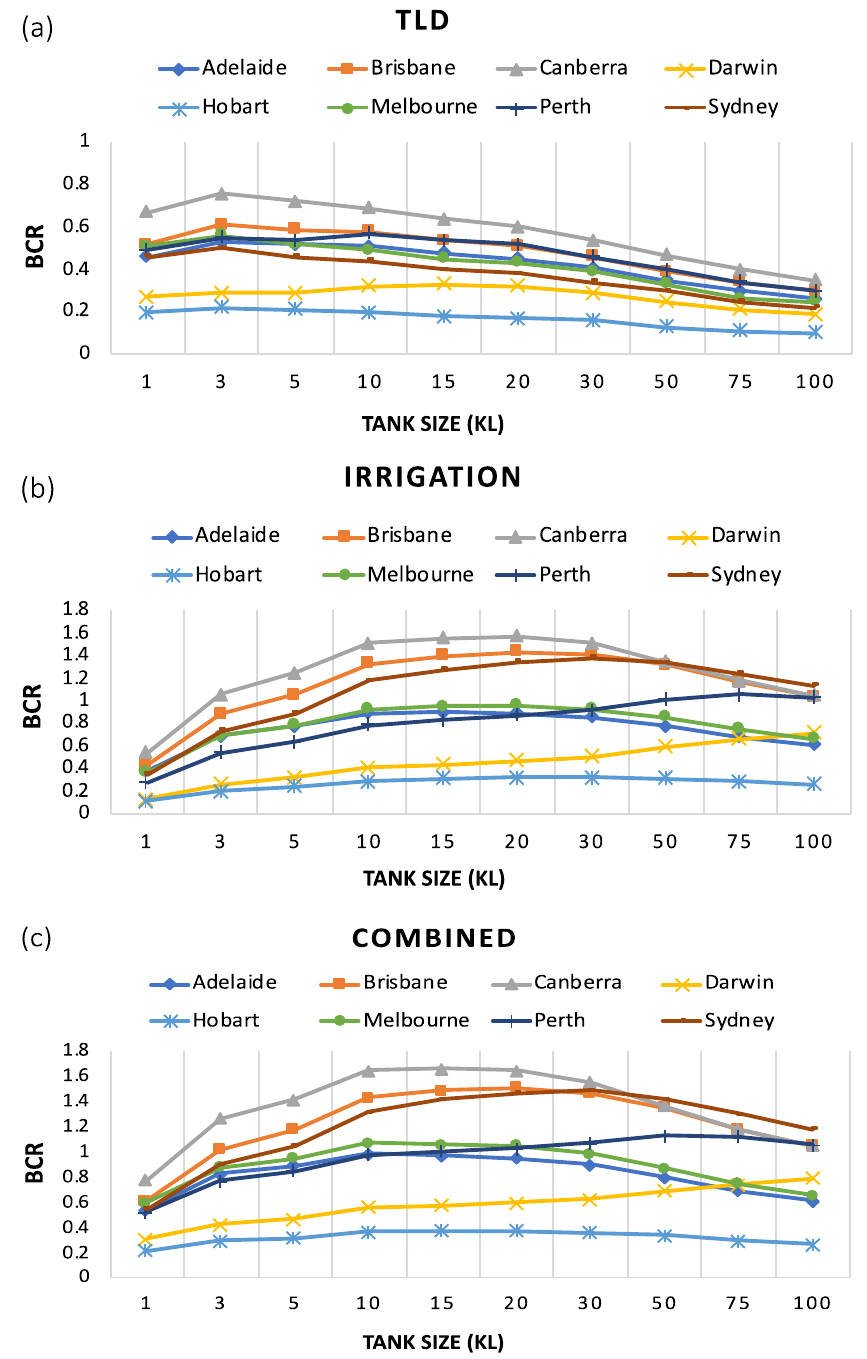
Figure 12. Plots showing BCR values of rainwater harvesting system for three water uses: ( a ) TLD use; ( b ) irrigation use; ( c ) combined use.